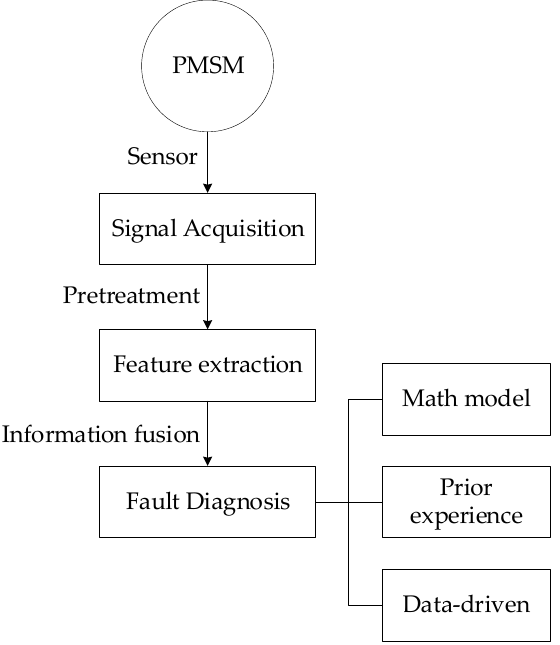
Figure 1. Fault diagnosis flowchart of permanent magnet synchronous motor (PMSM).